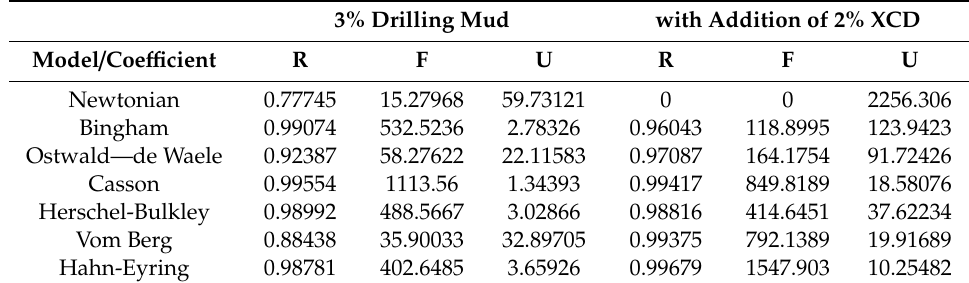
Table 5. Results of the rheological model selection obtained from Rheosolution 4.0 for drilling fluid samples (with and without adding polymer).